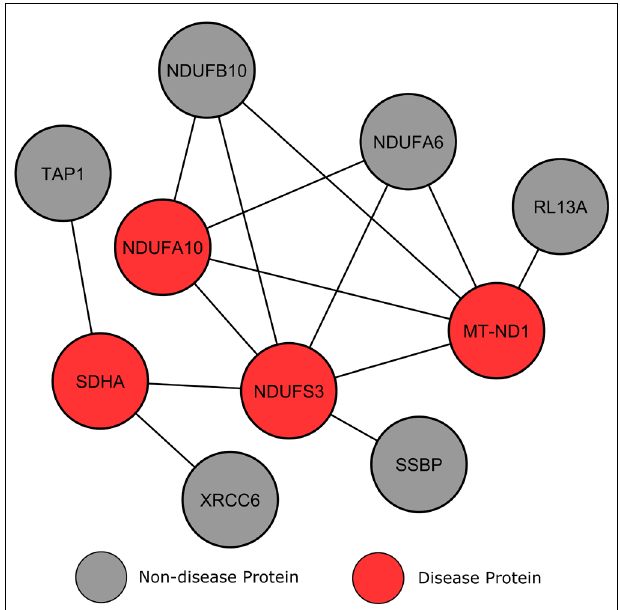
FIGURE 6 | Leigh syndrome gene clustering. Each circular node denotes a protein and a line illustrates an interaction between two proteins. the histone methyltransferases KMT2D (also known as MLL2) or KDM6A, causing a breakdown in the epigenetic control of active chromatin states (Hannibal et al., 2011). KS is a congeni- tal disorder presenting with multiple malformations of the facial area, ID and cardiac defects (Bokinni, 2012). In a number of cases, KS patients have no identified KMT2D or KDM6A gene mutations (Miyake et al., 2013). Whilst in these cases the cause of the disorder is unknown, these additional cases indicate that the disorder may show further heterogeneity (Bokinni, 2012).